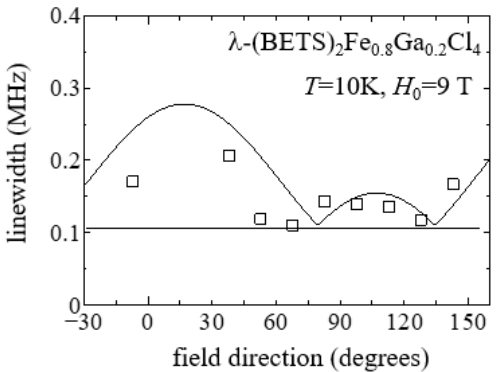
Figure 4. Angular dependence of the line width. The horizontal dashed line corresponds to the width of non-electronic origin. The solid line is the calculated value assuming charge disproportionation in the two-dimensional BETS conducting sheet. Details are given in the text.